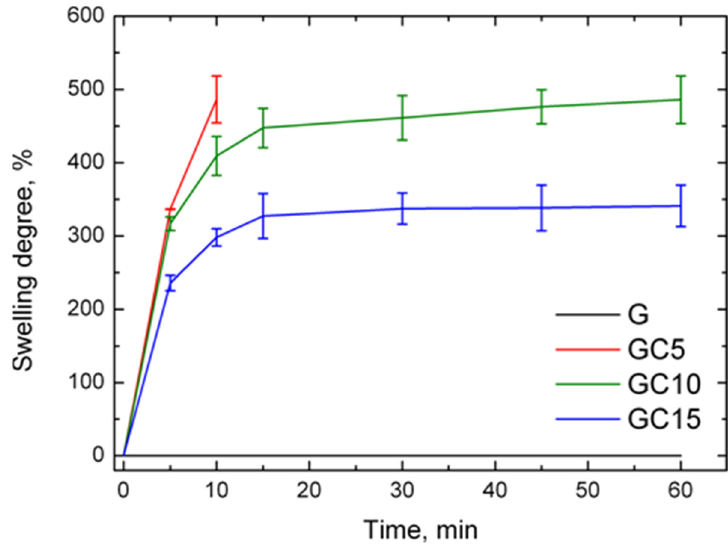
Figure 8. Swelling degree of gelatin and composite films immersed in water for 60